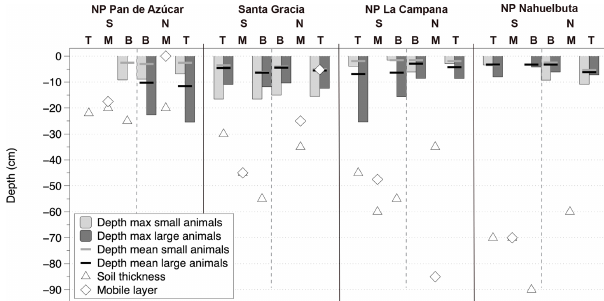
Figure 6. Animal burrowing depth as mean and maximum values from measurements in an arid to humid–temperate climatic gradi- ent; for comparison the following are included: the depth of mobile layer following Schaller et al. (2018) and soil thickness following Oeser et al. (2018). NP – National Park, N – north-facing slope, S – south-facing slope. T, M and B are indications of the position on a slope: T – top slope, M – mid-slope, B – bottom